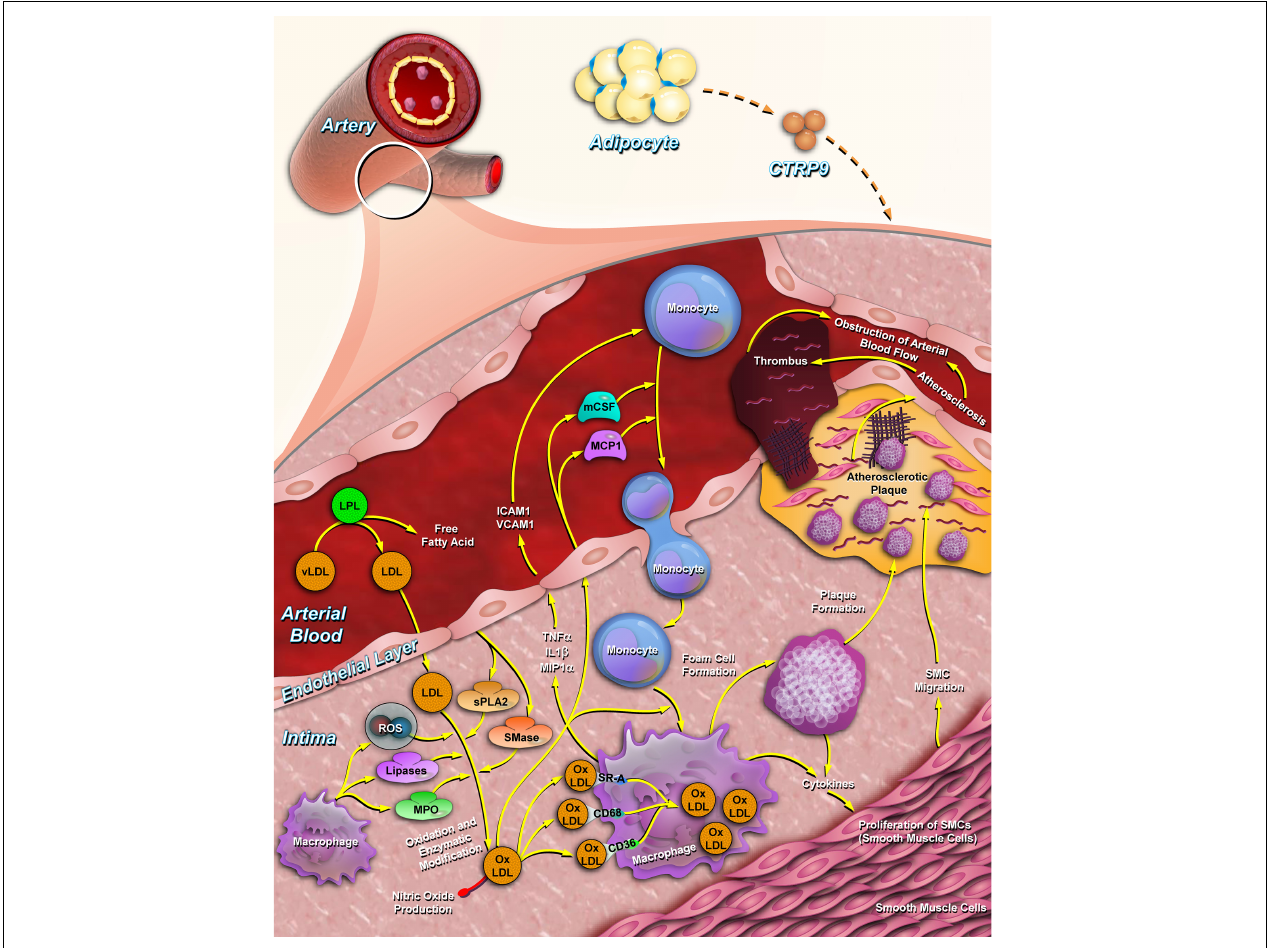
FIGURE 3 | CTRP9 inhibits atherosclerotic plaque formation. CTRP9 is synthesized by adipose tissue (relatively higher expressed in stromal vascular fraction) and secreted into the plasma. In arterial vessels, CTRP9 inhibits the cholesterol oxidation of low-density lipoproteins by lowering the secretion of inflammatory factors, such as IL-6, MCP-1, and TNF- α . CTRP9 reduces the adhesion and migration of monocytes to endothelial cells and promotes the foaming of macrophages by promoting cholesterol efflux from macrophages. CTRP9, C1q/tumor necrosis factor-related protein 9; IL-6, interleukin-6; TNF- α , tumor necrosis factor alpha; MCP-1, monocyte chemoattractant